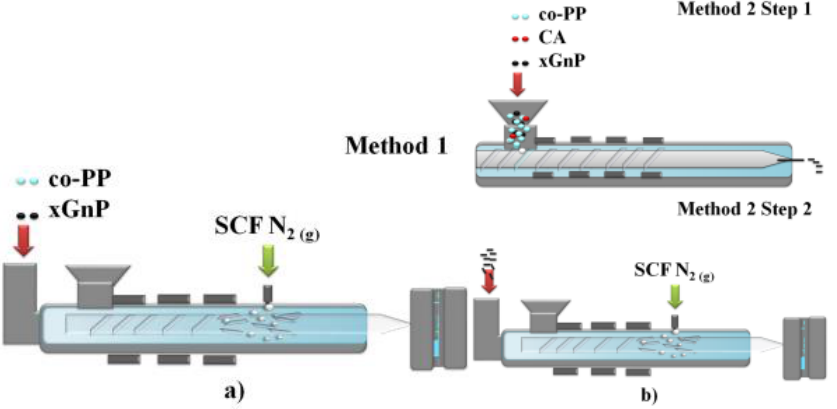
Figure 1. Experimental part design with elements of (1) ribs, (2) boss-screw nests, (3) welding dots, (4) grids, (5) joint nests, (6) flaps, and sound transmission loss. Locations of standard ISO test specimens for mechanical, scanning electron microscopy, and sound transmission loss measurements marked with dashed red line.